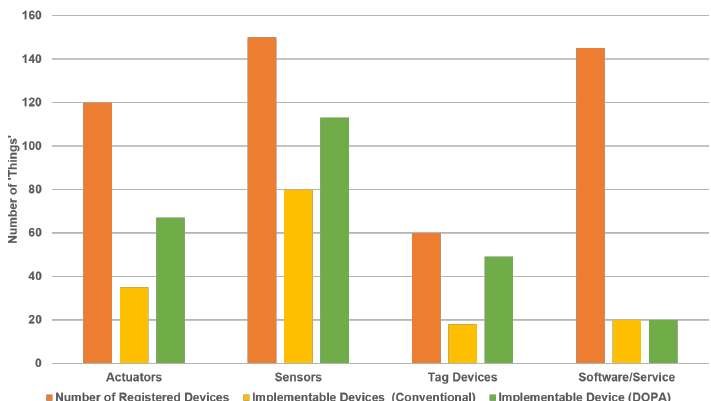
Figure 14. Evaluation for implementable devices.